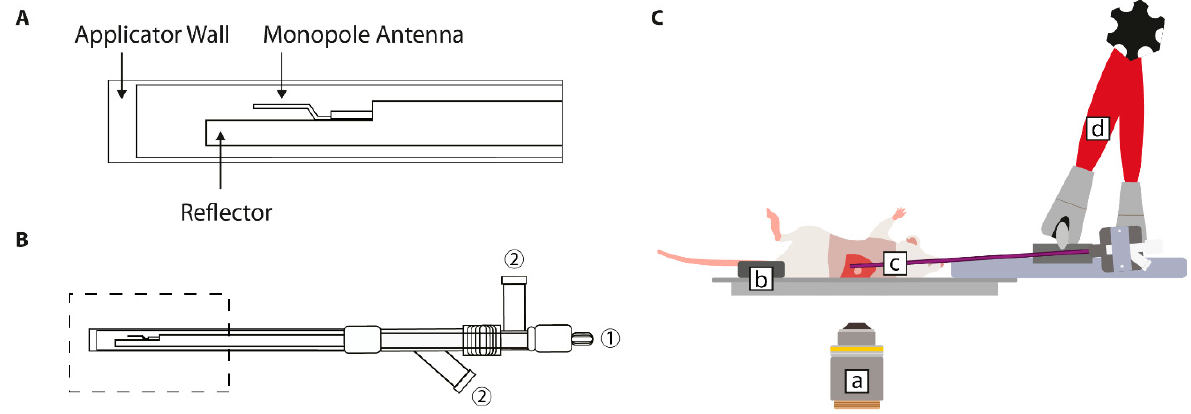
Figure 4. Illustrations of the hyperthermia model using a directional microwave hyperthermia antenna. ( A ) The radiating part of the applicator consisted of a coaxial monopole cable, which was surrounded by a copper outer conductor. At the end of the monopole, the outer conductor was shaped as a reflector by adopting a hemicylindrical form. The outer wall consisted of polyimide, which encapsulated the water circulating through the applicator. ( B ) The marked section indicates the applicator part as shown in A. Three connectors were located on the other side of the device: one for the RF power ① and two for the water circulation ② . ( C ) The directional microwave hyperthermia antenna set-up consisted of (a) microscope objective, (b) heating platform for the maintenance of the animal’s core body temperature, (c) coaxial monopole antenna, and (d) flexible arm with 360° rotation.